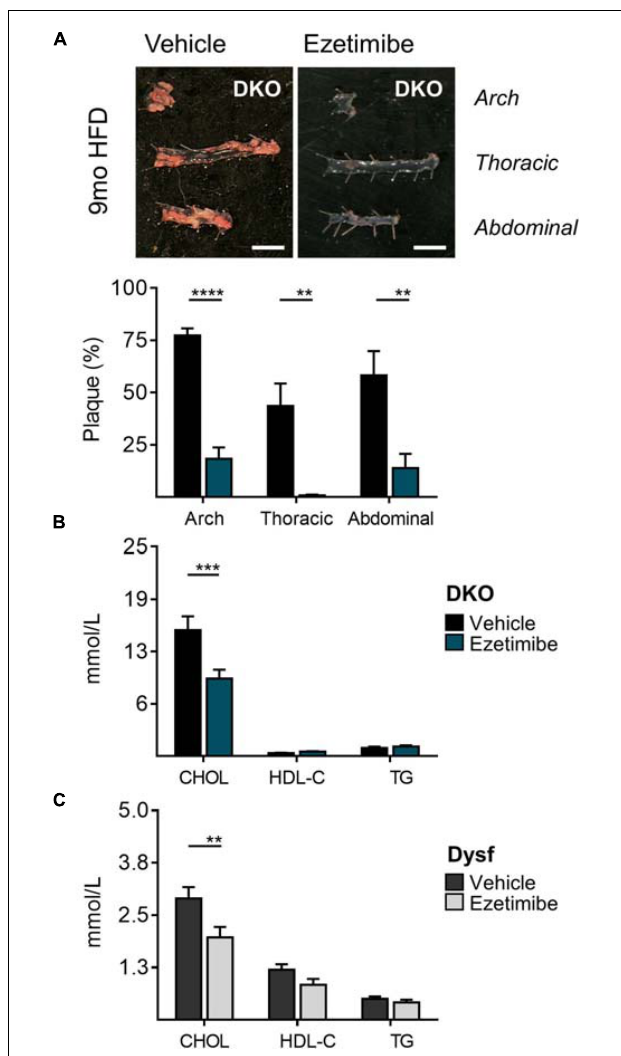
FIGURE 4 | Decreased atherosclerosis and plasma cholesterol levels in DKO mice treated with the cholesterol absorption blocker ezetimibe for 9 months. (A) Representative images and quantification of plaque accumulation from aortic arch, thoracic and abdominal segments, (B) total plasma cholesterol (CHOL), high density lipoprotein (HDL-C), and triglyceride (TG) levels from HFD-fed DKO mice, and (C) CHOL, HDL-C, and TG levels from HFD-fed Dysf-null mice treated with vehicle or ezetimibe for 9 months. DKO: Vehicle ( N = 11), Ezetimibe ( N = 7); Dysf: Vehicle ( N = 14), Ezetimibe ( N = 9); Significance at P < 0.01 (**); P < 0.001 (***); P < 0.0001 (****); Two way ANOVA Sidak’s post hoc tests. Mean + SEM. Scale bar = 0.5